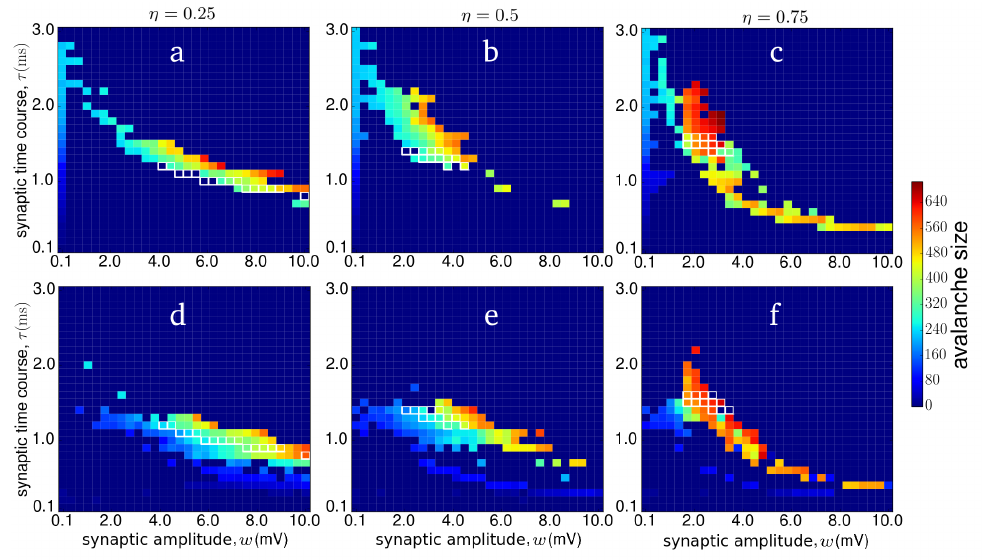
Figure 10. Location of minimum synaptic cost for different avalanche sizes: ( a ) η = 0.25, ( b ) η = 0.5, and ( c ) η = 0.75. Location of minimum number of spikes: ( d ) η = 0.25, ( e ) η = 0.5, and ( f ) η =